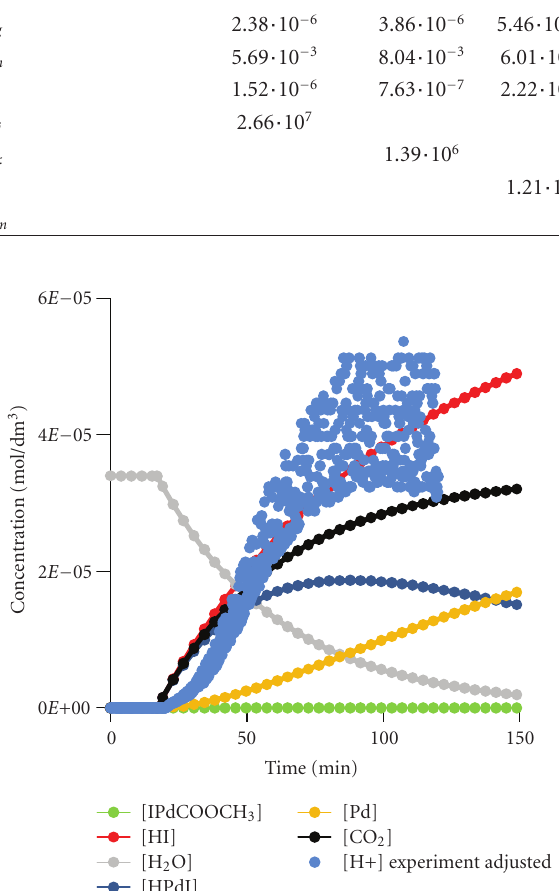
Figure 9: Fitted data using Model 4 against experimental data presented in Figure